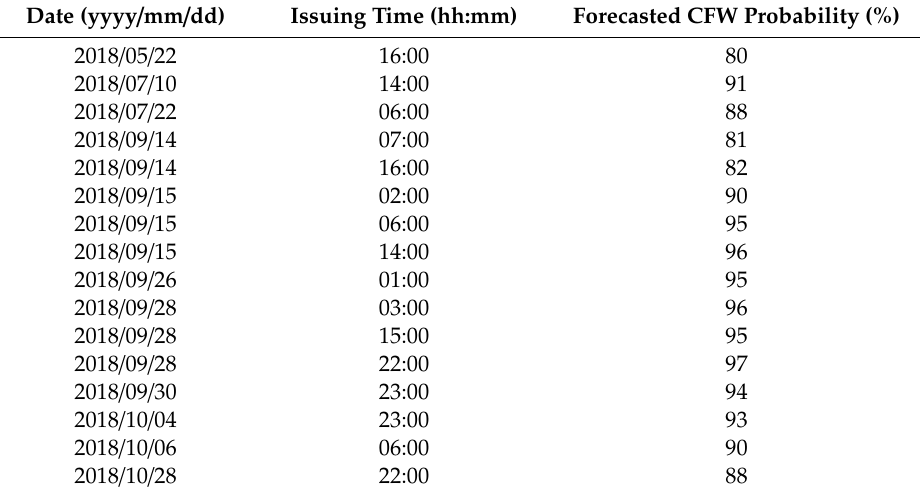
Table 5. Swell alert issuing time and forecasted CFW probability.